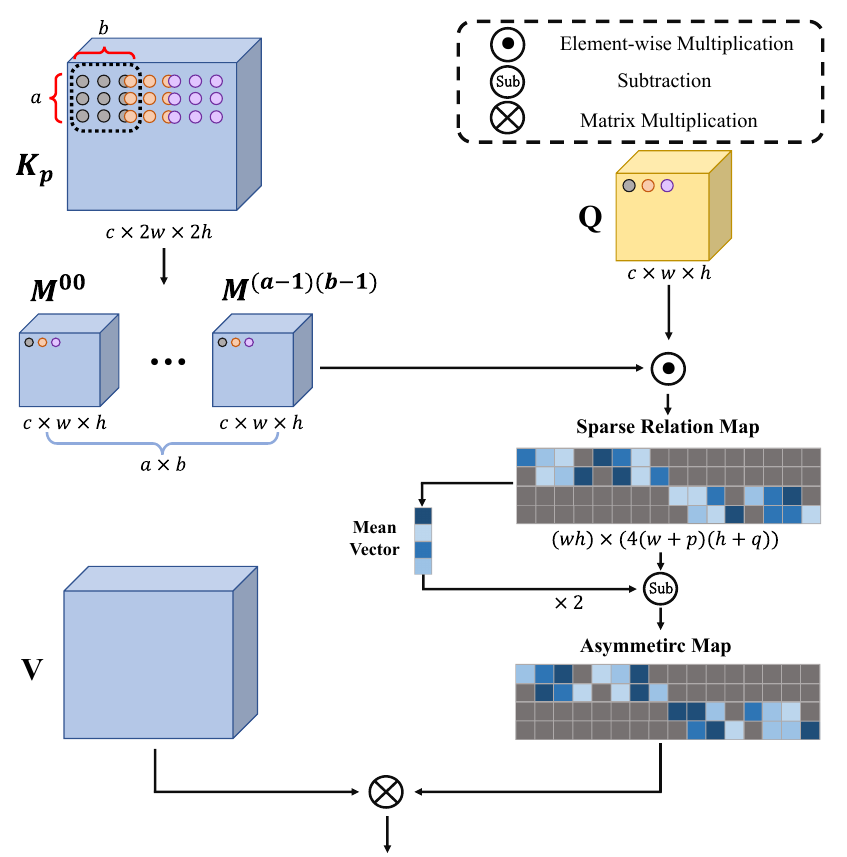
Figure 8. The architecture of SLA with three inputs: K p , Q , and V . The K p is generated from K after padding with zeros. After using a sparse relation extraction and an inverse method, the V values are multiplied by the asymmetric map to obtain the final